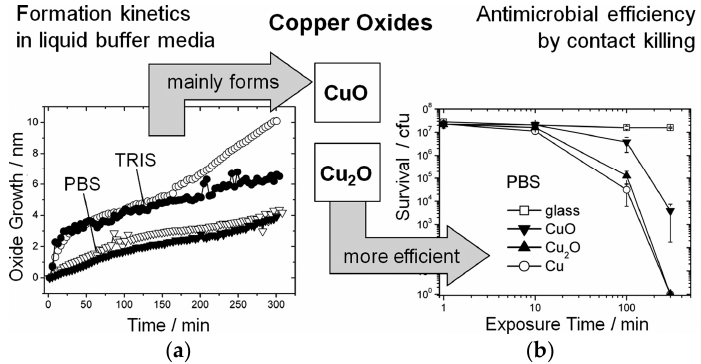
Figure 5. ( a ) Plot showing oxide growth versus oxidation time in PBS and in Tris; ( b ) Plot survival of E. hirae exposed to glass, Cu, CuO and Cu 2 O at different times